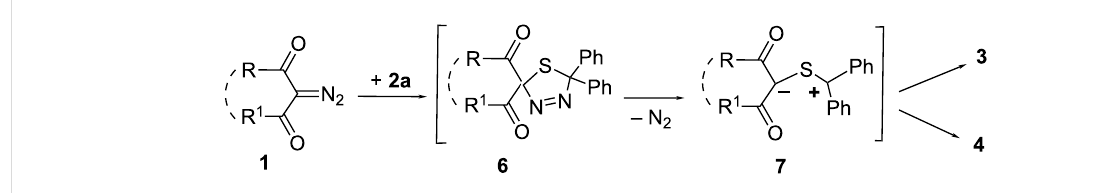
(PCM) [22], and for the case of thioketone 2b , all calculations were performed for the gas